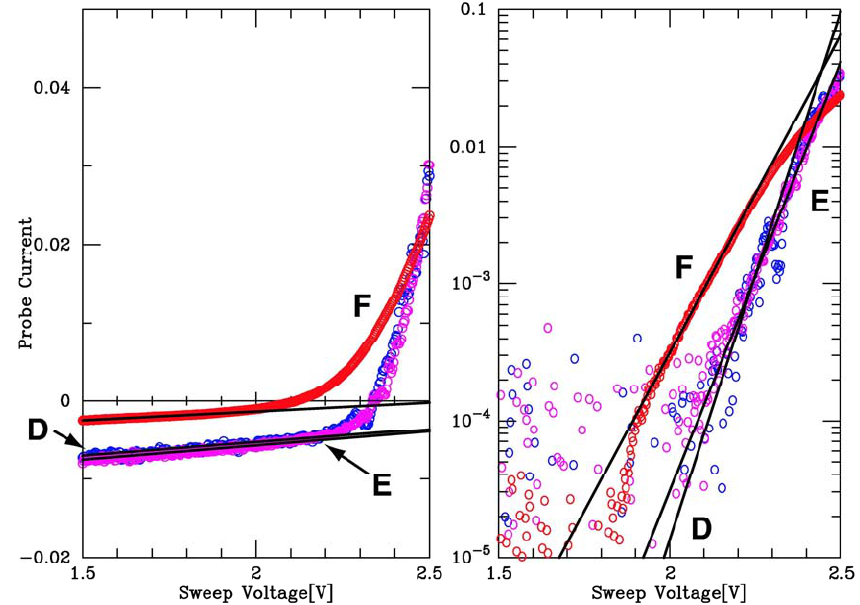
Fig. 6b. Same as Fig. 6c but for E, F, and D, which are marked in Fig.